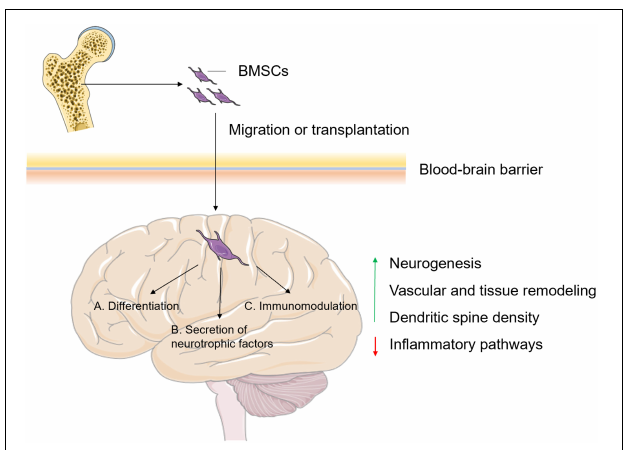
FIGURE 2 | The possible mechanisms of BMSCs involved in the regulation of brain functions. BMSCs can be transplanted directly into the injury site, or they can actively migrate to the injured site after crossing the BBB, where (A) they differentiate into neuronal lineages and oligodendrocytes; (B) elicit nerve regeneration by secreting neurotrophic factors and (C) act as immunomodulatory cells, eventually leading to promoted neurogenesis, vascular and tissue remodeling, and dendritic spine density and inhibited inflammatory pathways. BMSCs, bone mass-derived mesenchymal stem cells; BBB, blood-brain barrier. Figures were produced using Servier Medical Art,